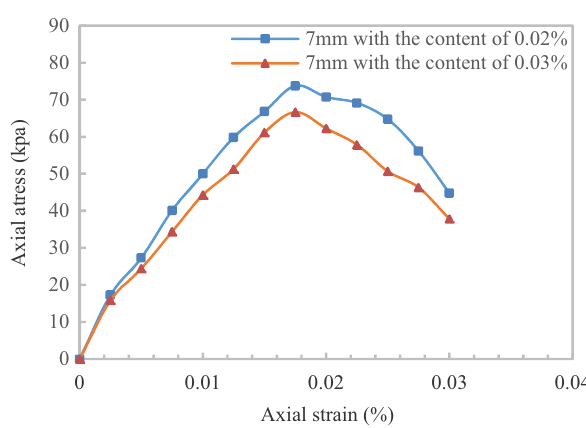
Figure 11: The stress – strain curves of di ff erent reinforcement ratios with EPS particle size of 7 mm.